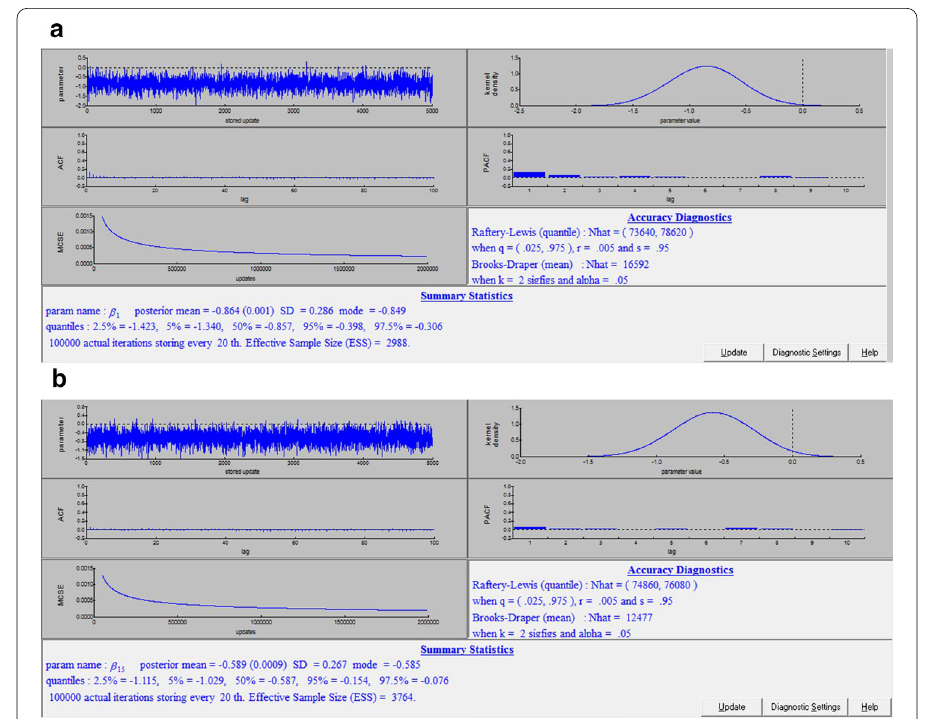
Fig. 2 a convergences for β 1 . b convergences for β